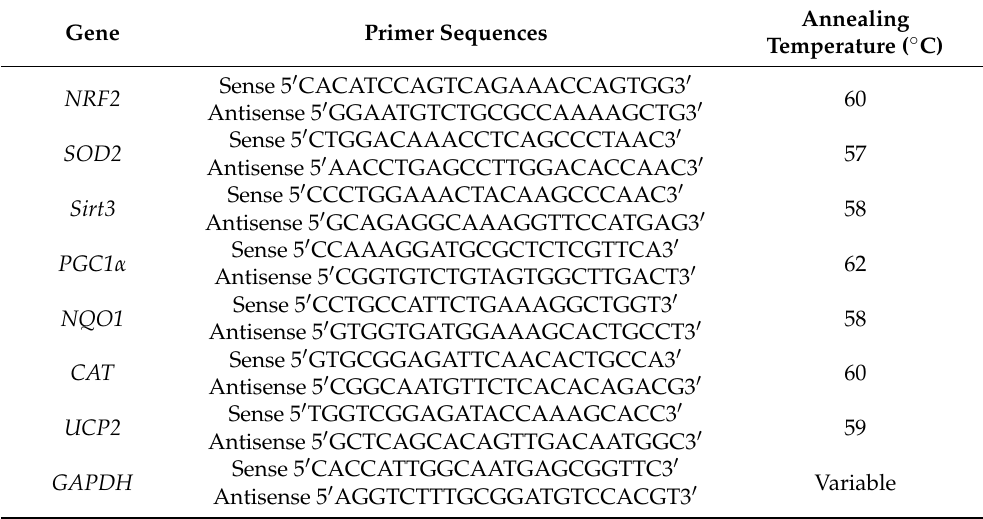
Table 2. Primer sequences and annealing temperatures of the genes of